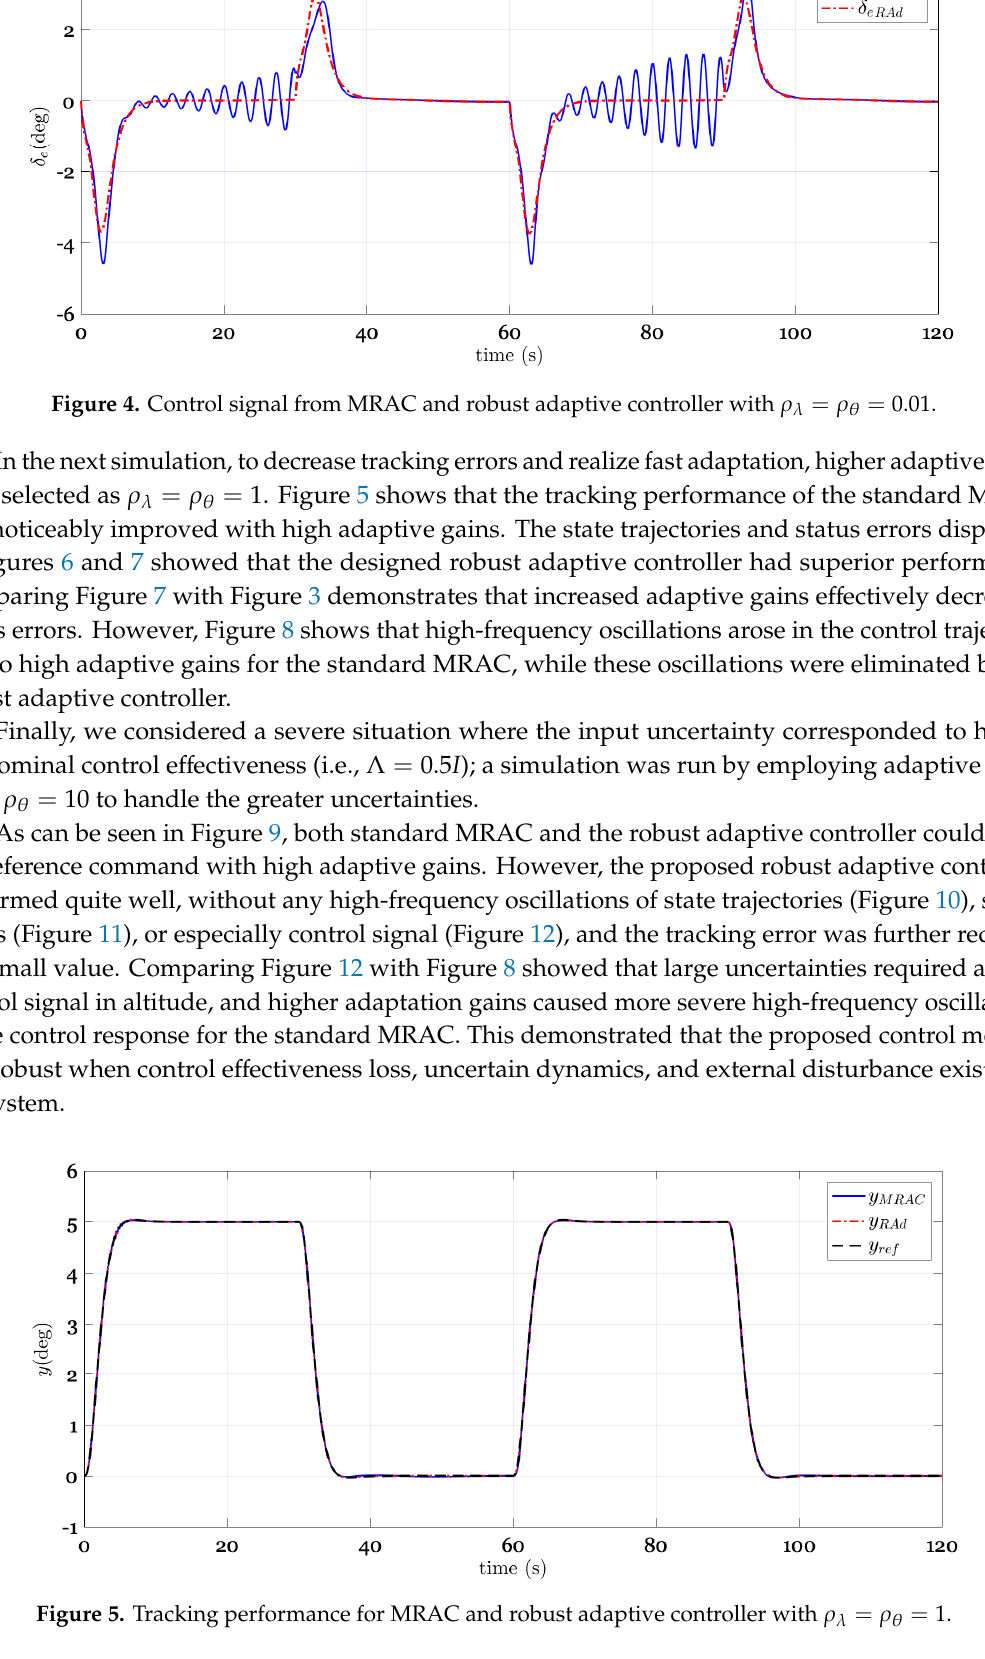
Figure 3. Status errors from MRAC and robust adaptive controller with